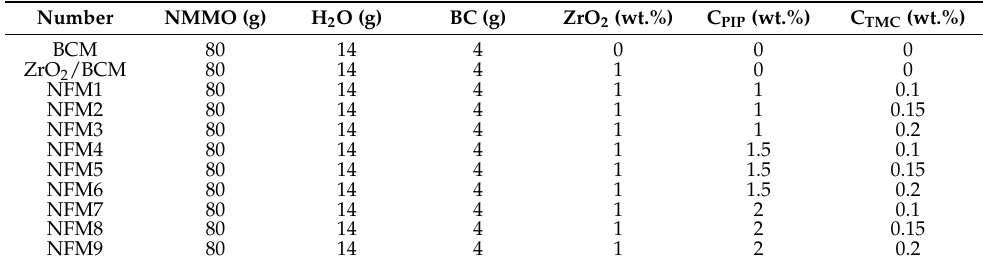
Table 1. Compositions of the different